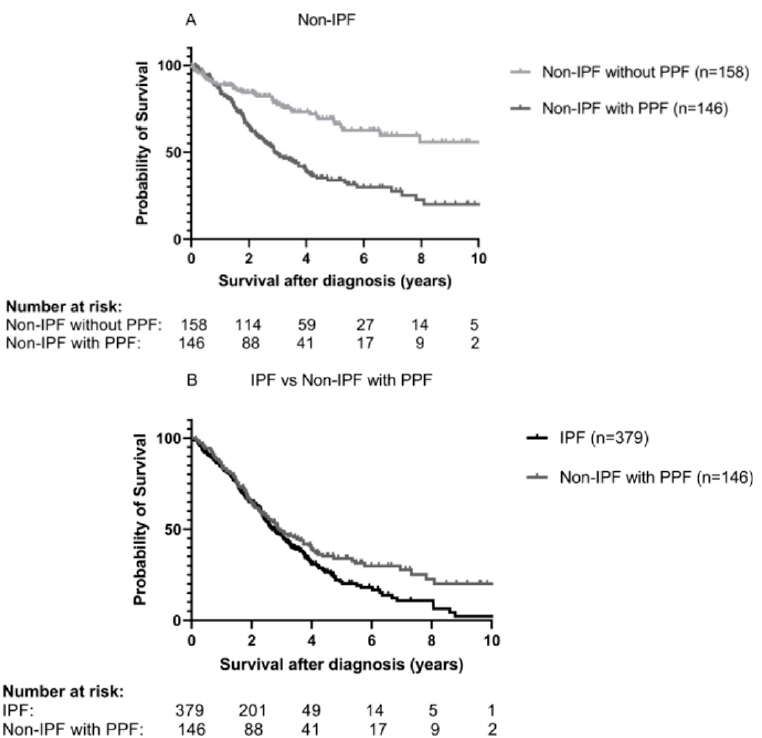
Figure 6. Transplant-free survival in ( A ) non-IPF, stratified into patients without PPF (light grey line, n = 158) and with PPF (grey line, n = 146). The median TPF survival was 10.1 ± 1.8 years in non-PPF and 2.9 ± 0.4 years in PPF ( p < 0.001) and in ( B ) patients with IPF (black line, n = 379) and non-IPF with PPF (grey line, n = 146). The median TPF was 2.7 ± 0.2 years in IPF and 2.9 ± 0.4 years in non-IPF with PPF ( p = 0.037). IPF: Idiopathic pulmonary fibrosis, PPF: Progressive pulmonary fibrosis and TPF: Transplant-free.